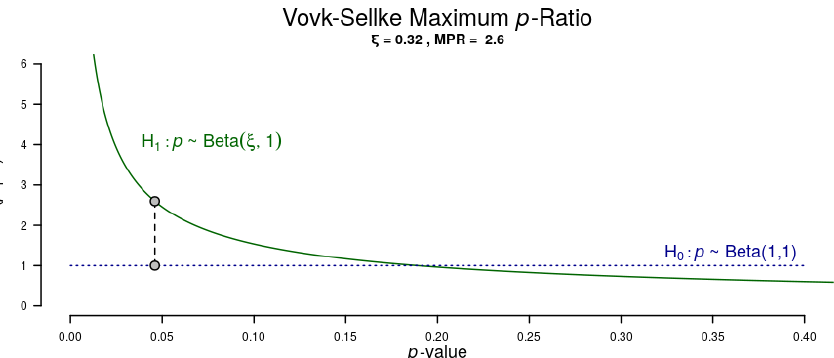
Table 2. Emotional intelligence and resilience. Pearson correlations and descriptive plots.